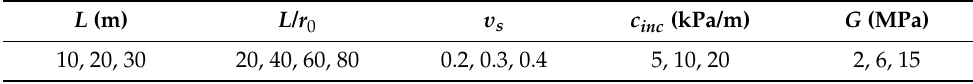
Table 4. Combination of pile geometries and parameters